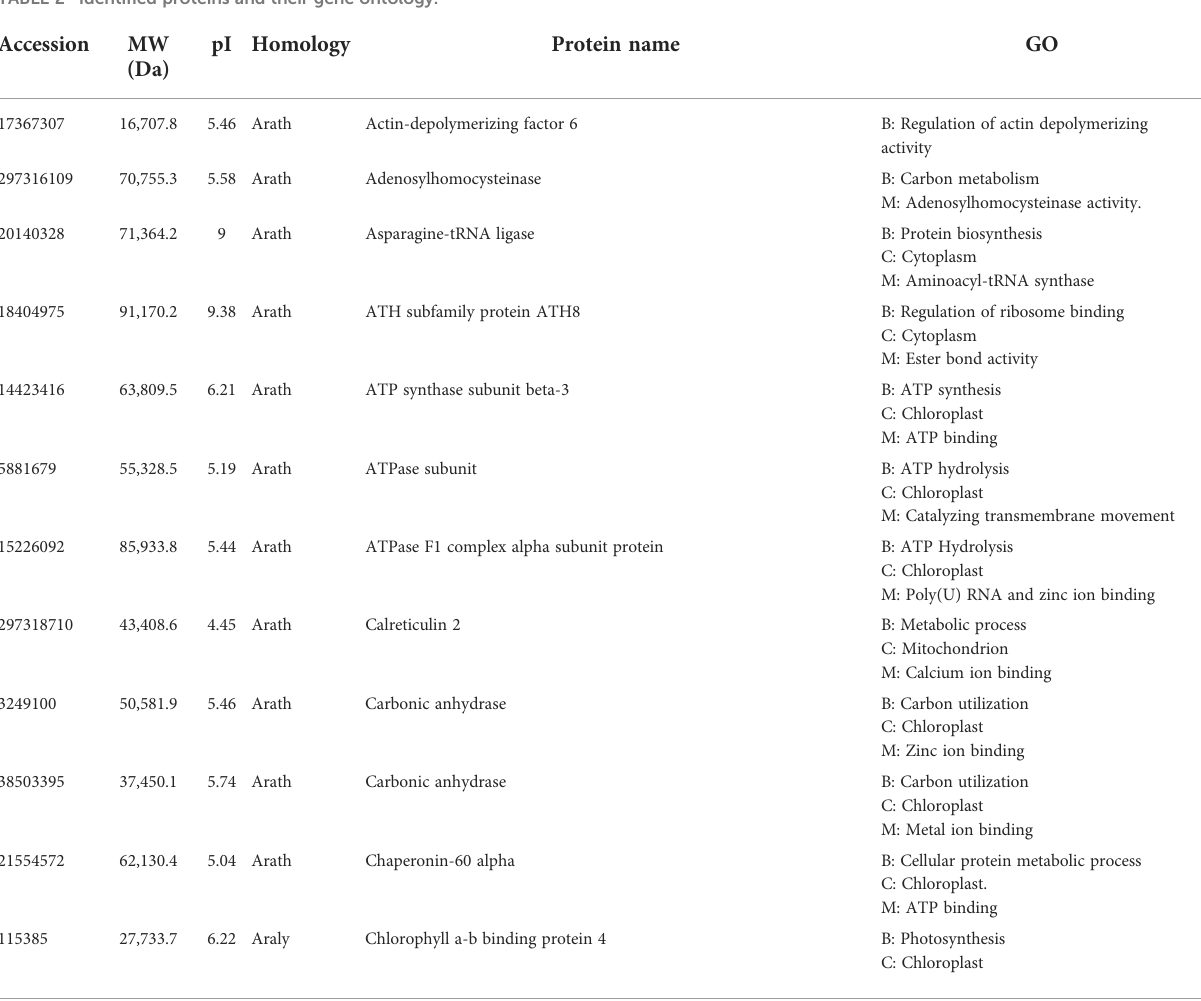
TABLE 2 Identi fi ed proteins and their gene